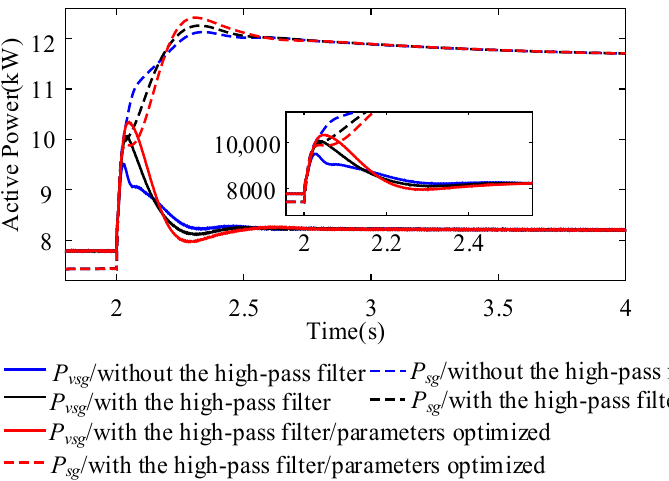
Figure 11. The simulation result of active power in three cases under the condition of load sudden increase.